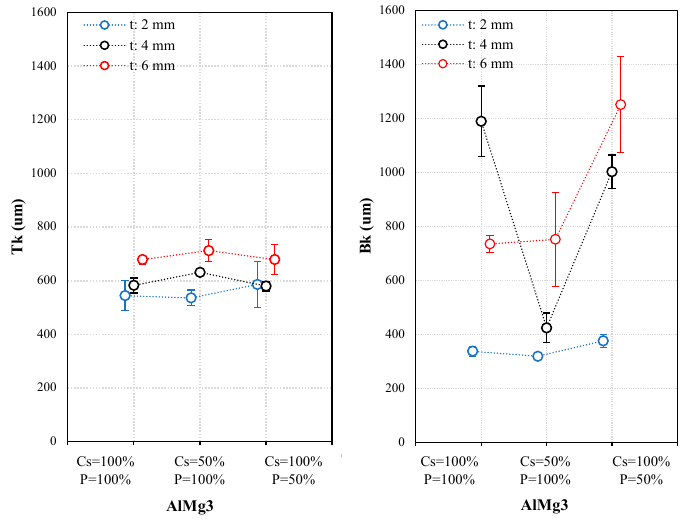
Figure 5. Kerf width for AlMg3 in relation to cutting conditions and thickness.